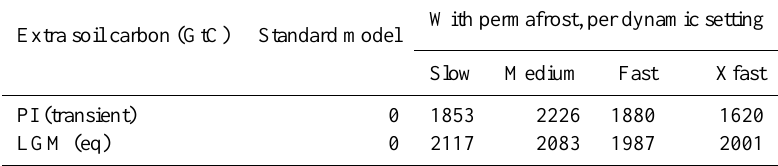
Table 8. Modelled permafrost-region extra land carbon stocks with respect to standard model per model setting. Extra soil carbon